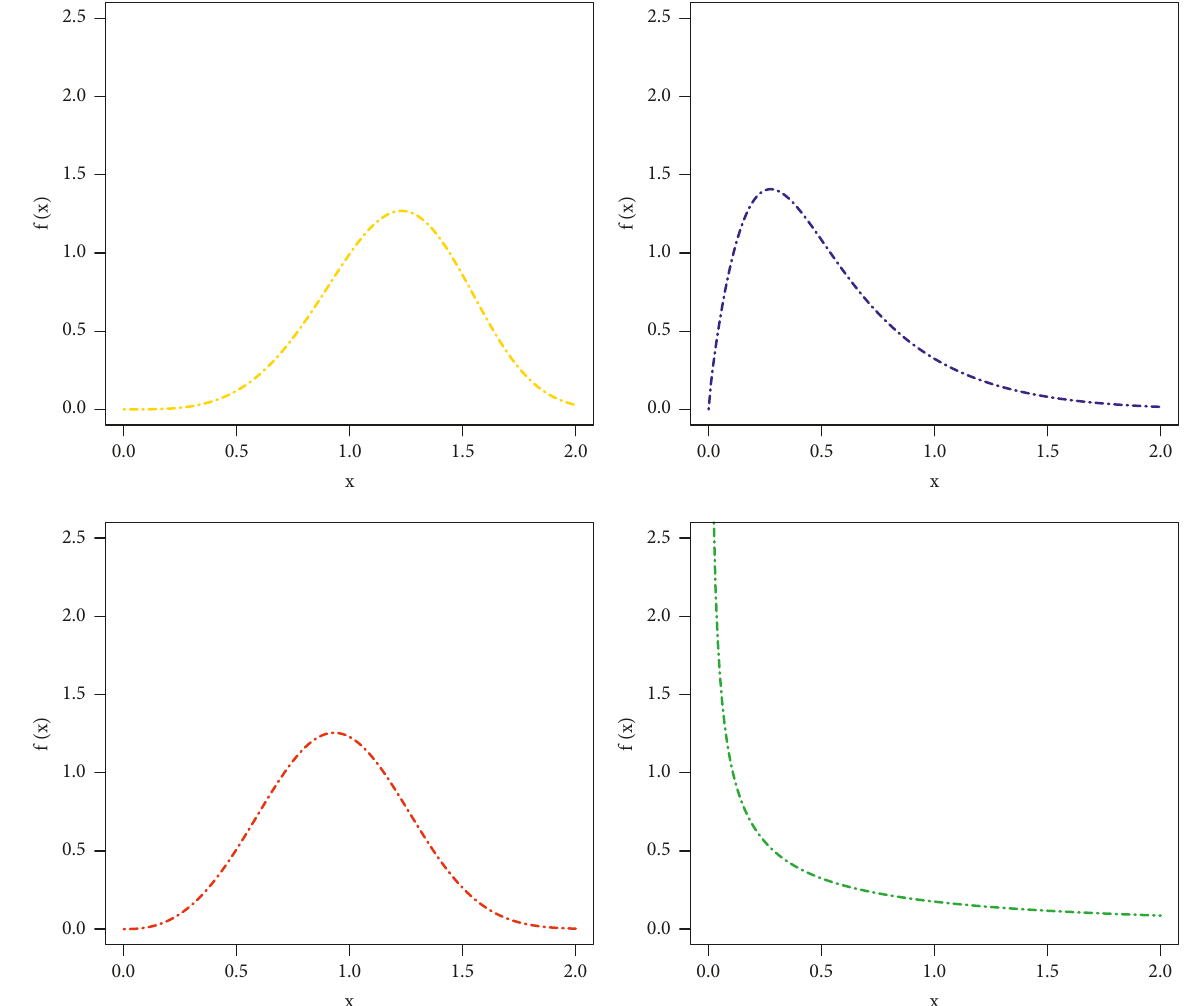
Figure 1: A visual behavior of f ( x ; φ , σ , δ , κ ) for different values of φ , σ , δ > 0, and κ >